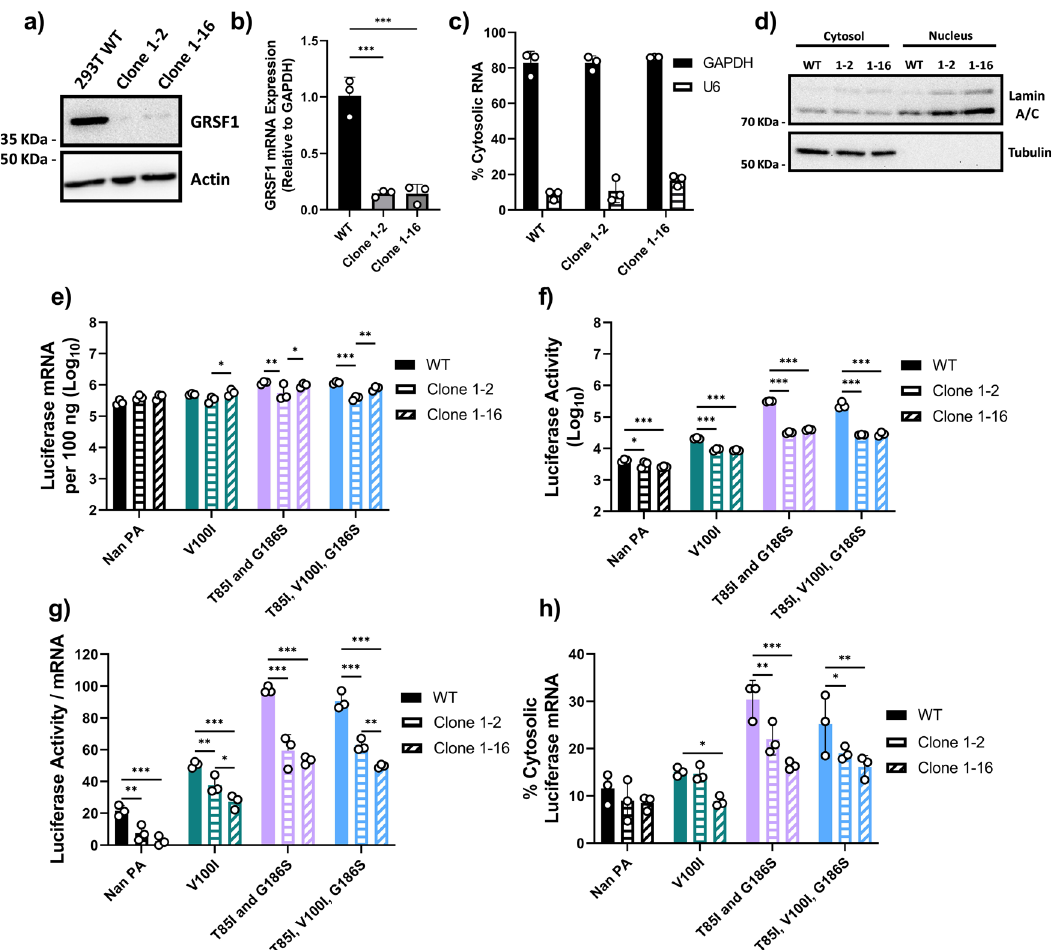
Fig. 7 GRSF1 knockdown reduces cytosolic accumulation and translation ef fi ciency. a Lysates from WT 293 T or 293 T cells stably expressing shRNA for GRSF1 (clone 1 – 2 and clone 1 – 16) were used for immunoblotting to determine GRSF1 and β -actin expression. b GRSF1 mRNA expression from total cell lysates was determined by qRT-PCR using the 2^ ΔΔ Ct method. c , d WT 293 T or shRNA GRSF1 clone 1 – 2 or 1 – 16 cells were fractionated into nuclear and cytosolic fractions. c Percentages of cytosolic GAPDH mRNA and U6 snRNA are shown. d Representative image of immunoblotting analysis for tubulin (cytosolic marker) and lamin (nuclear marker) detected by speci fi c antibodies. e – h WT 293 T or shRNA GRSF1 clone 1 – 2 or 1 – 16 cells were transfected with Cal NP, PB1, PB2, pPolI-NP-luc and Nan PA with the indicated mutations. e Luciferase mRNA was quanti fi ed by qRT-PCR. f Luciferase activity was determined by the Dual-Luciferase Reporter Assay system. g Ratio of luciferase activity per mRNA, transformed to a normal distribution. h Cells were fractionated into nuclear and cytosolic fractions and mRNA was quanti fi ed by qRT-PCR. Percentages of cytosolic luciferase mRNA are shown. Error bars show the means plus/minus standard deviations ( n = 3 biological replicates). One-way or Two-way ANOVA followed by Tukey ’ s multiple comparison test * P < 0.05, ** P < 0.01, *** P <